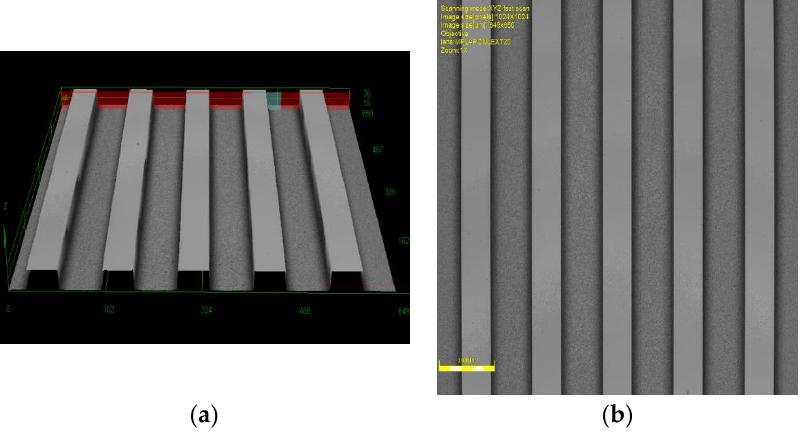
Figure 6. ( a ) SEM 3D and ( b ) SEM top view of the terahertz wideband filter.